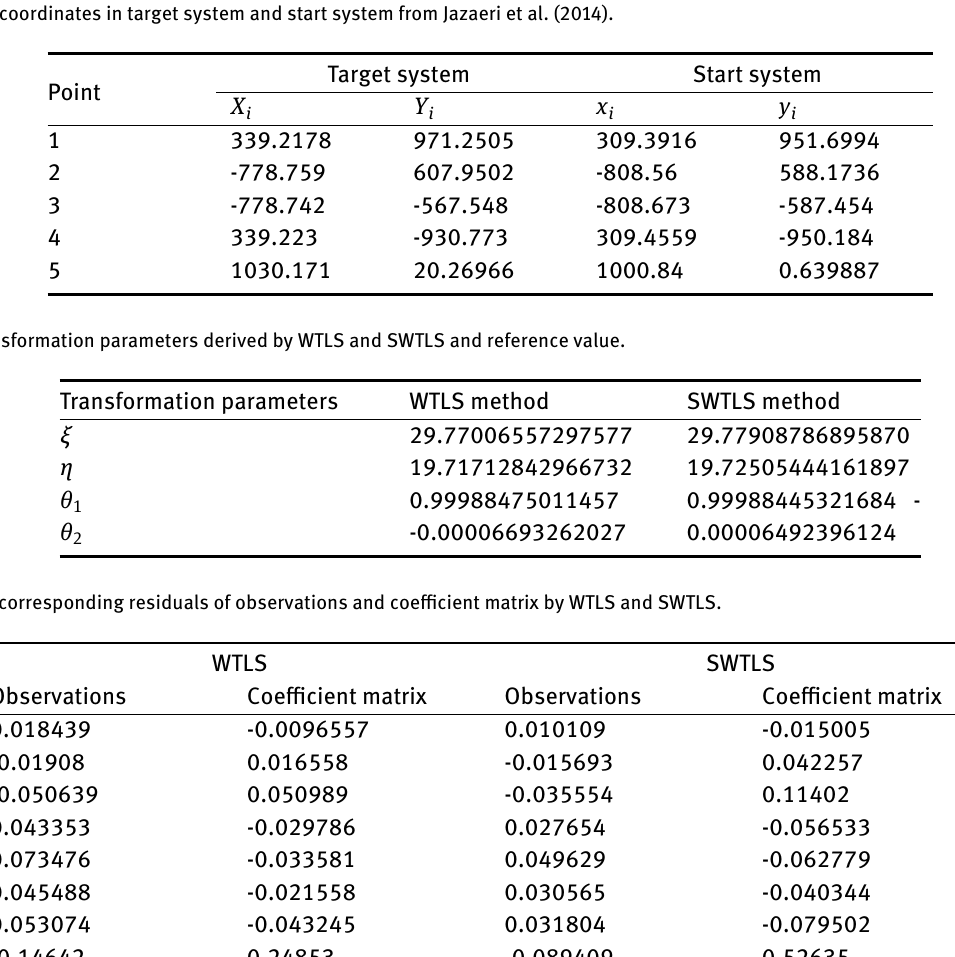
Table 3: The coordinates in target system and start system from Jazaeri et al. (2014).